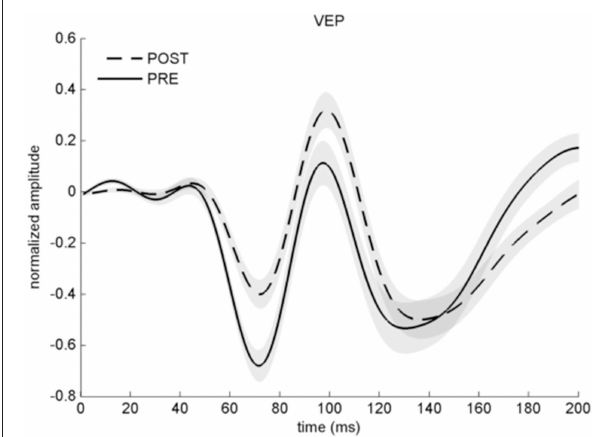
FIGURE 3 | Averaged VEP before (solid line) and after stimulation with checkerboard reversals (dashed line) across all participants. Note that the y-axis represents arbitrary units as VEP amplitude is normalized. Error shades indicate 1 ±